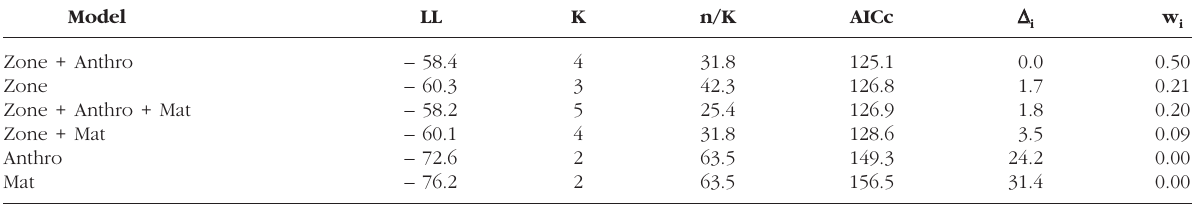
Anthro = anthropogenic food consumption; Mat = Microtus sp. and Arvicola terrestris consumption; LL = maximised log-likelihood; K = number of estimated parameters; n/K = number of observations/K; AICc = second-order Akaike index criterion; ∆ AICc and minimum AICc; w = Akaike weights. i Table IV. – Model selection to explain E. multilocularis